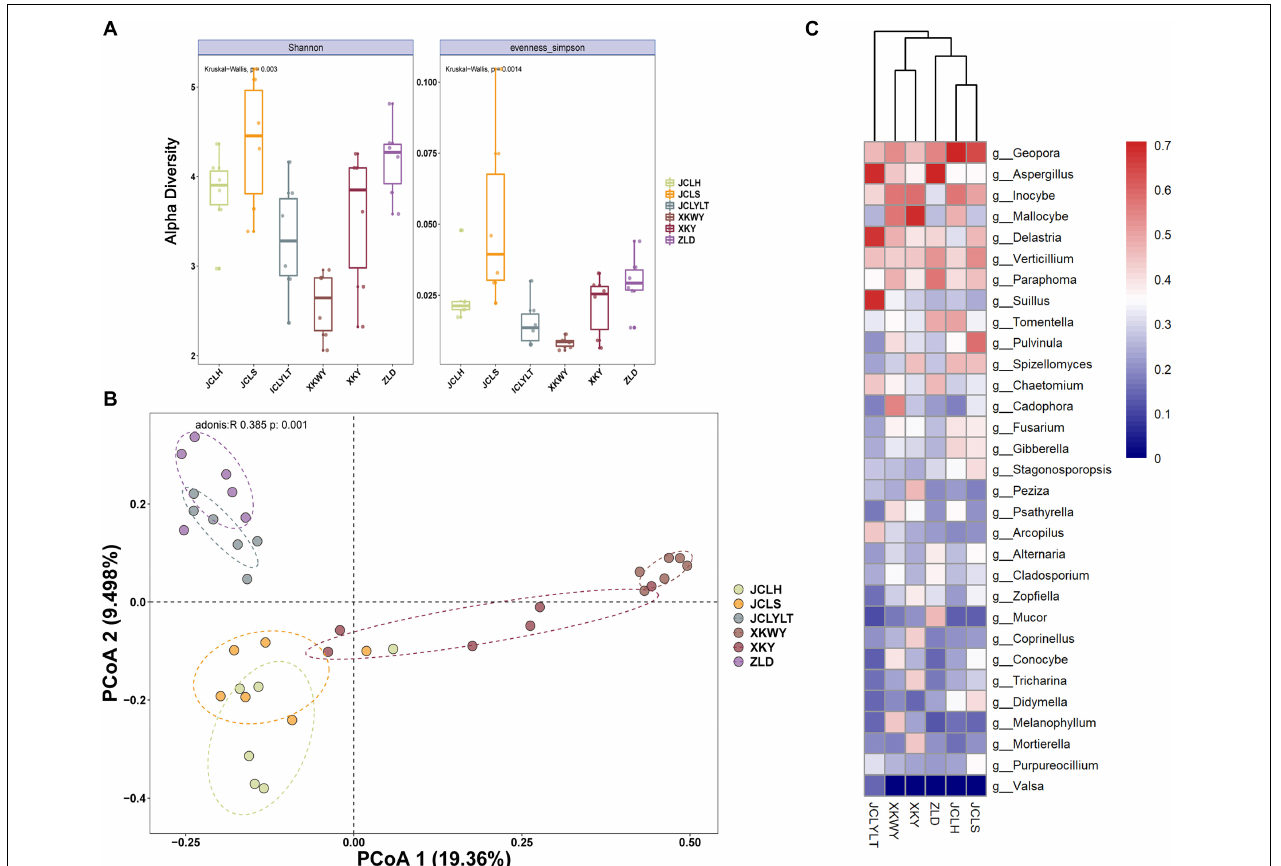
FIGURE 5 | (A) Alpha diversity analysis based on the OTUs account for the species richness using eveness Simpson index and species diversity using Shannon index. (B) Bray–Curtis dissimilarity principal coordinate analysis (PCoA) of fungal community structures in different soils. (C) Characteristic fungal populations with significant community differences in different soils.